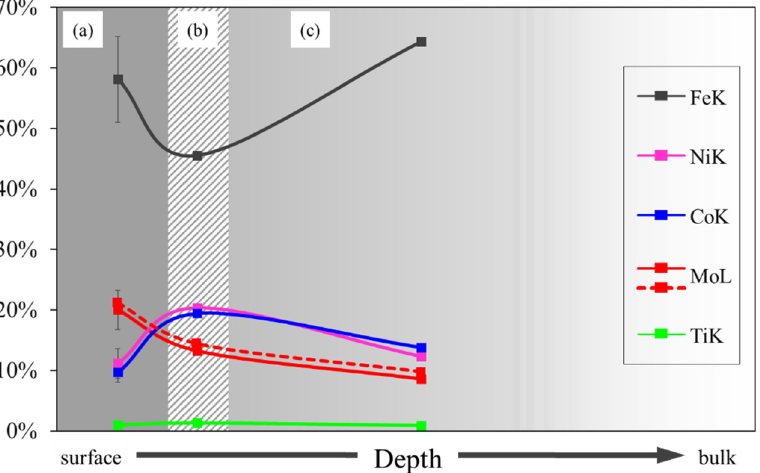
Figure 6. Qualitative composition of the elements by EDS microanalysis along the depth of the sample: ( a ) external layer, ( b ) intermediate layer and ( c ) Bulk. Several EDSs were obtained independently in each layer from z direction and then the results were compiled in this figure. The intermediate layer is rich in nickel and cobalt, austenite stabilizers.